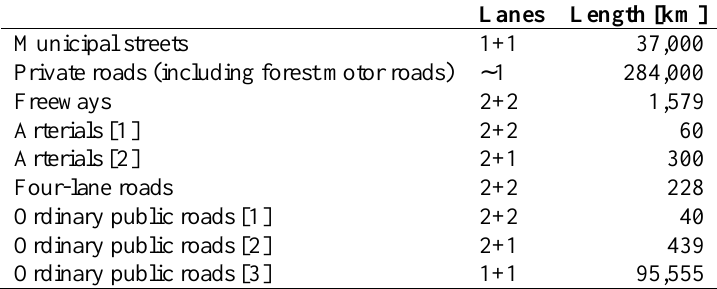
Table 1. The Swedish road grid